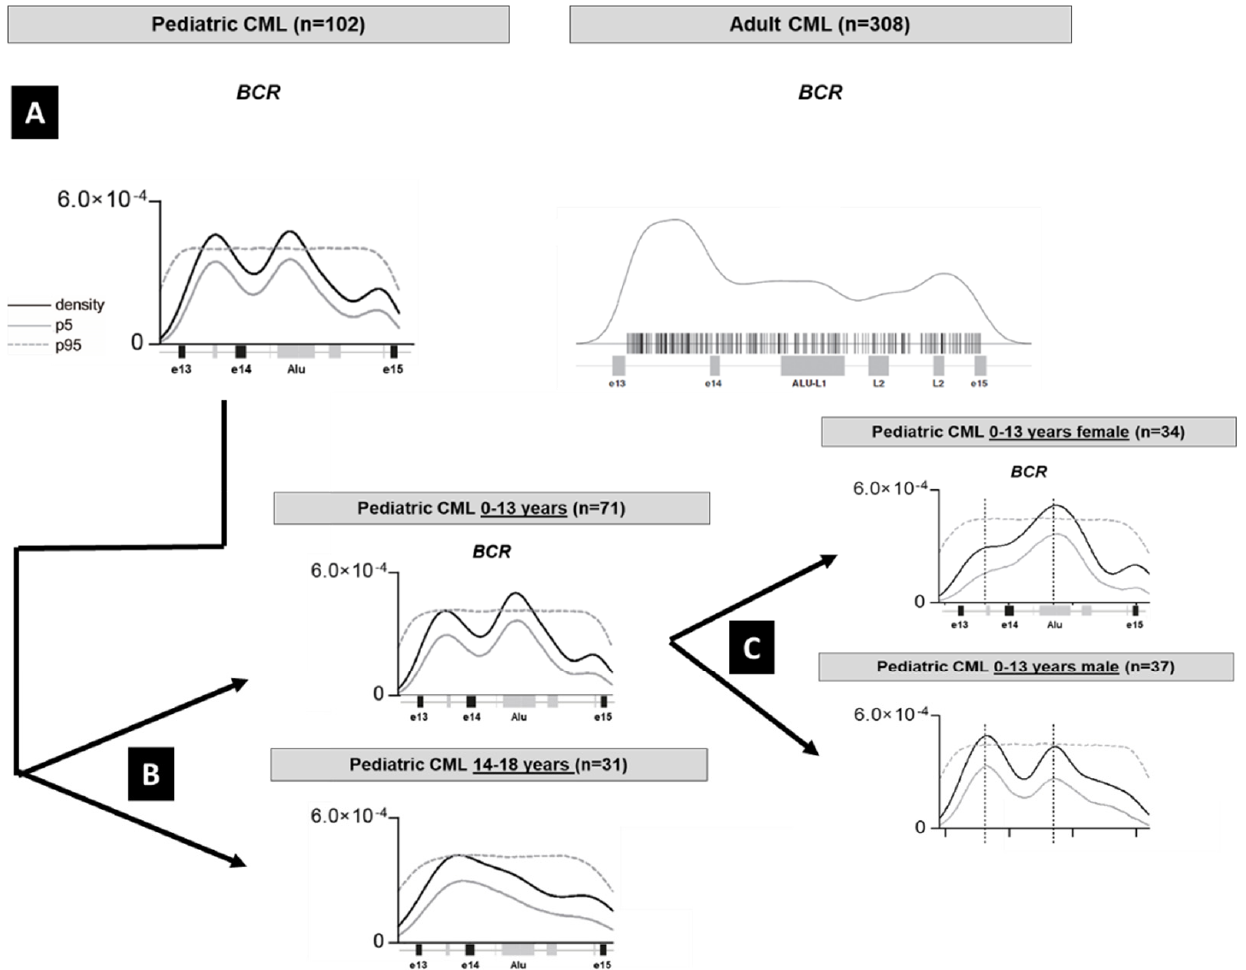
Figure 2. Illustration of the genomic DNA breakpoint distribution in the BCR gene and Kernel density analysis. For details see reference [59]. ( A ) When the pattern in 102 pediatric patients with CML is compared to 308 adult patients with CML as reported in the literature, pediatric CML shows a bimodal distribution which is also found in Ph1 positive acute lymphoblastic leukemia. ( B ) The bimodal “ALL-type” breakpoint can be found more frequently in prepubertal children and ( C ) in the prepubertal cohort is detectable more frequently in boys. In the Kernel plots the gray lines denote the 5% and the dotted line the 95% confidence intervals.